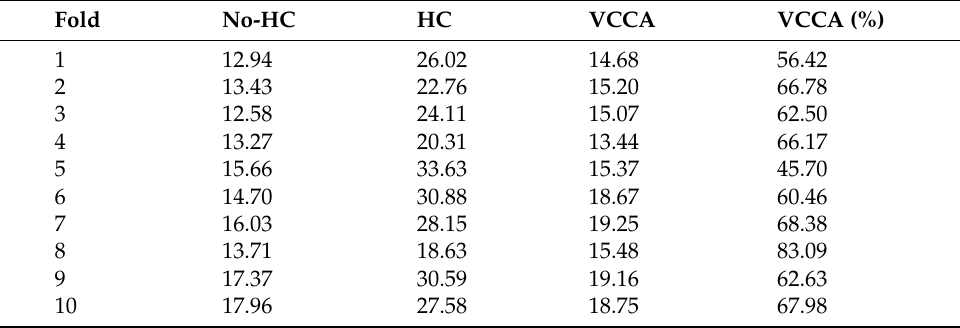
Table 7. The training times in seconds for Dataset